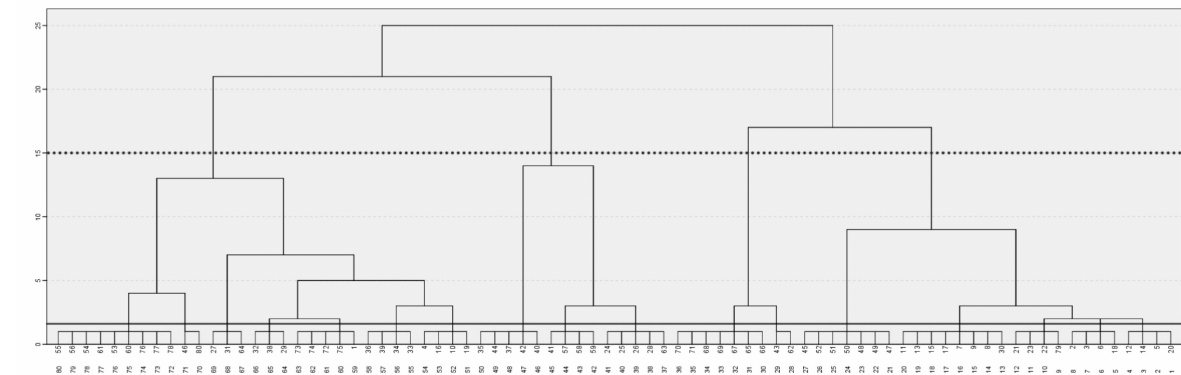
Figure 3. Diagram of clustering of 80 samples to 34 representative samples. is 17 cluster training sample cut-offs; ...... is 4 cluster validation sample cut-offs.